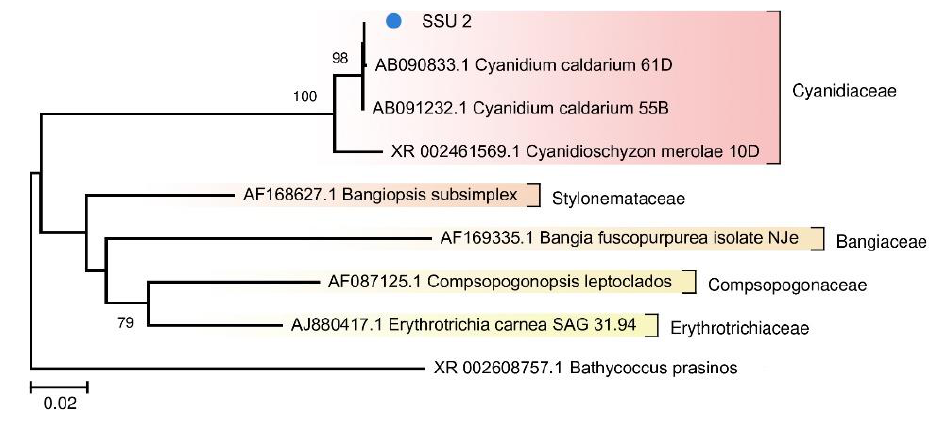
Figure 6. The phylogenetic tree of the SSU rRNA sequence of the red alga from the FAU community and other representatives of Rhodophyta from the NCBI nt database (The Tamura–Nei substitution model with gamma distribution and invariant sites (TN93 + G + I)).